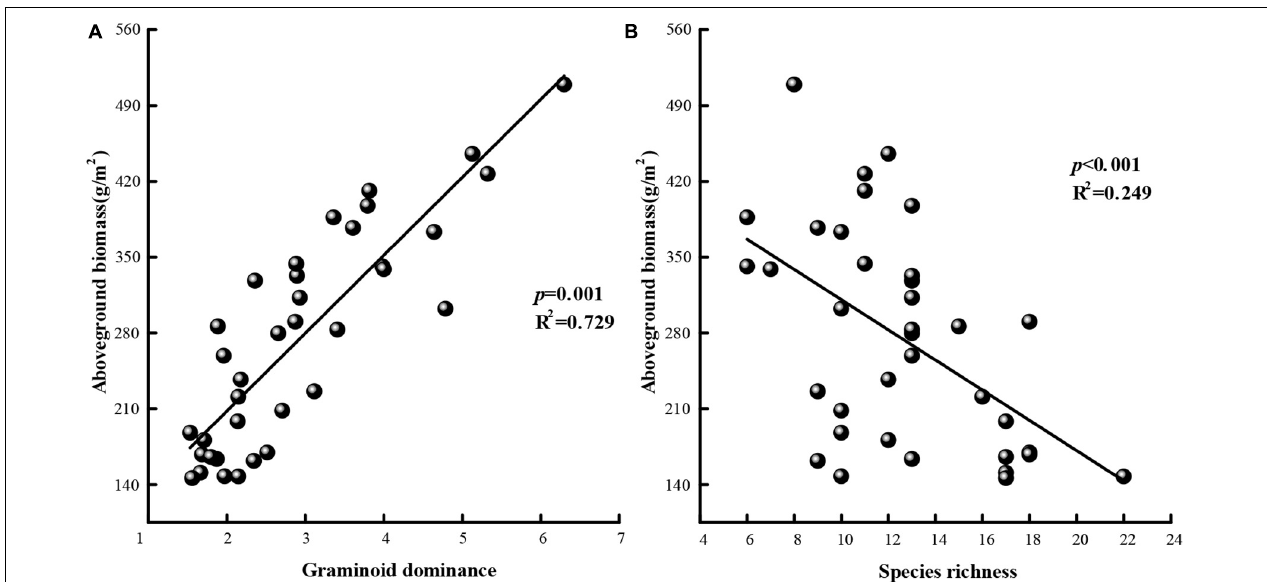
FIGURE 6 | Aboveground biomass in terms of (A) graminoid dominance and (B) species richness. Fitted lines are based on least-squares regression. Graminoid dominance is expressed as the ratio of graminoid cover relative to the cover of non-graminoids.